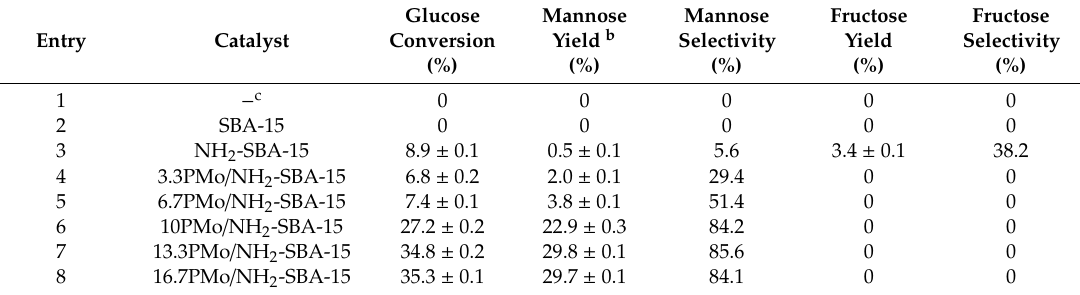
Table 2. Catalytic performance of the catalysts for glucose epimerization.